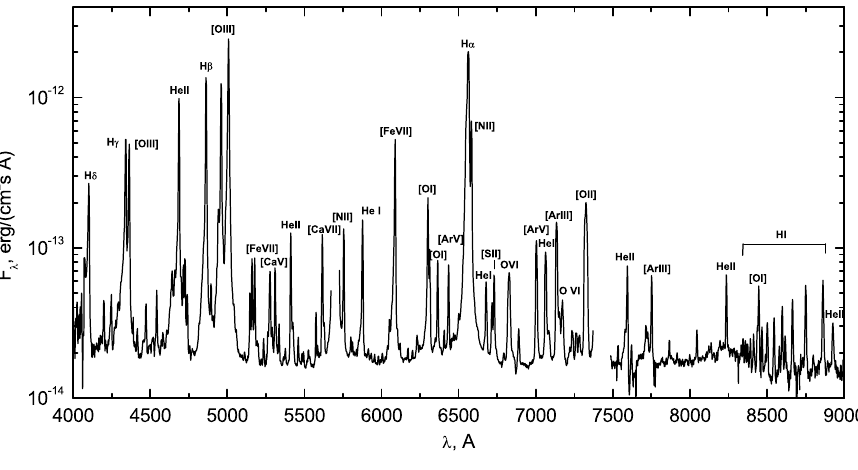
Fig. 5. The spectrum of V1016 Cyg in 2012. The spectrum covers the 4000(cid:21)9000 (cid:6)A wavelength range. Most of the detected strong emission lines are